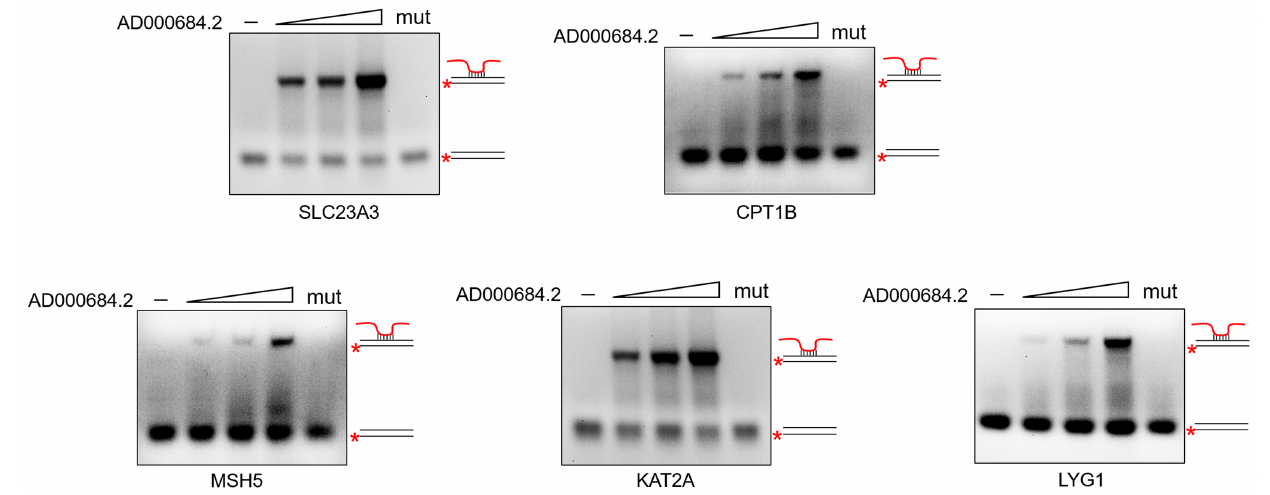
Figure 4. AD000684.2 forms RNA–DNA triplexes with the promoter region of regulated gene. The 0.5 pmol double-stranded 5 (cid:48) FAM-labeled oligonucleotide comprising TTS with a molar excess (40-, 80-, and 160-fold) of AD000684.2 RNA fragment (+367/+576) or 80-fold AD000684.2-TFO-mut fragment was incubated at 37 ◦ C for 1 h, and the formation of RNA–DNA triplexes was monitored by EMSA. * (FAM)-tagged DNA